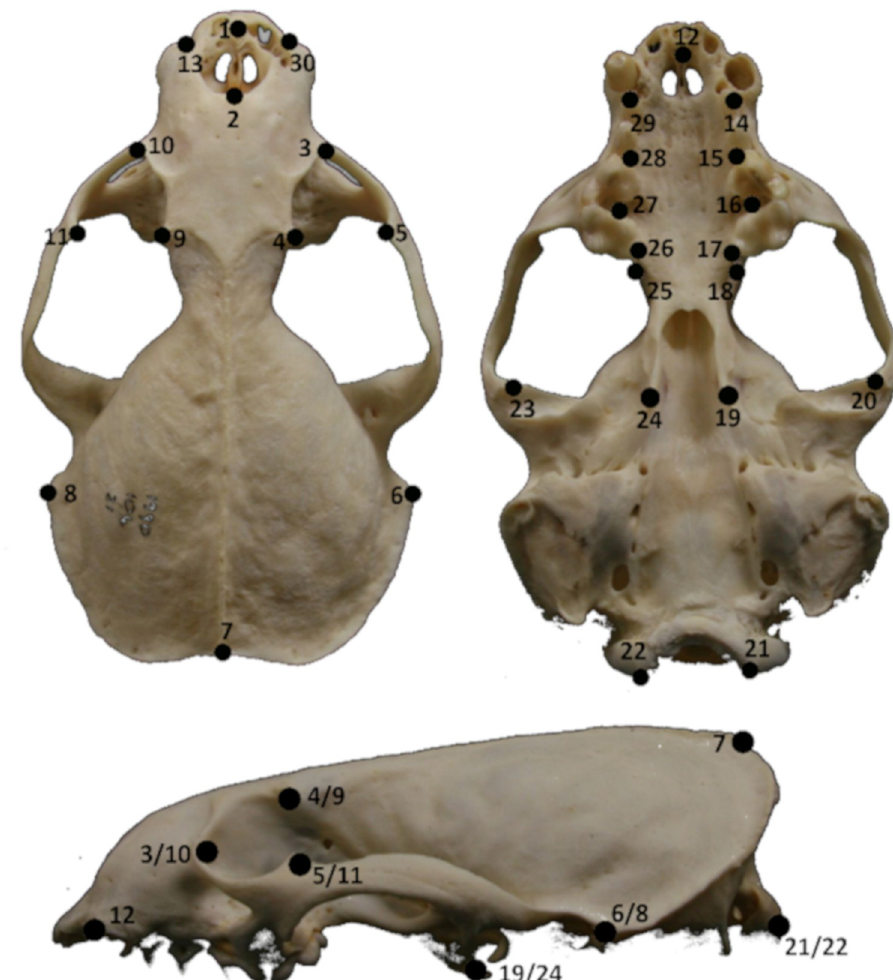
Fig 2. Location of anatomical landmarks collected on 3D models of otter skulls. Landmarks are defined as follows: 1 = Superior premaxilla; 2 = nasal suture; 3–10 = lacrimal; 4–9 = postorbital process 5–11; = zygomatic arch;6– 8 = mastoid process; 7 = intersection of temporal line and sagittal crest; 12 = prosthion; 13–30 = premaxilla and nasal bone suture; 14–29 = canine alveoli; 15–28 = carnassial alveoli; 16–27 = carnassial alveoli; 17–26 = toothrow; 18– 25 = palatine; 19–24 = pterygoid; 20–23 = glenoid cavity; 21–22 = occipital condyle.